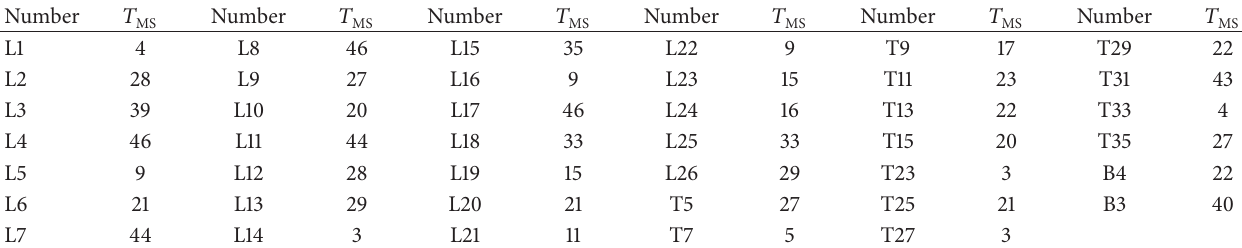
stands for the maintenance starting period). MS